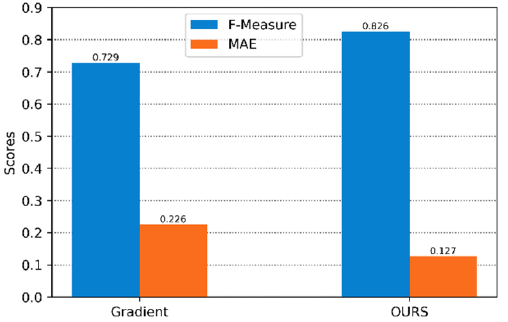
Figure 7. F ‐ Measure and MAE obtained by GrabCut for two focus calculation methods.